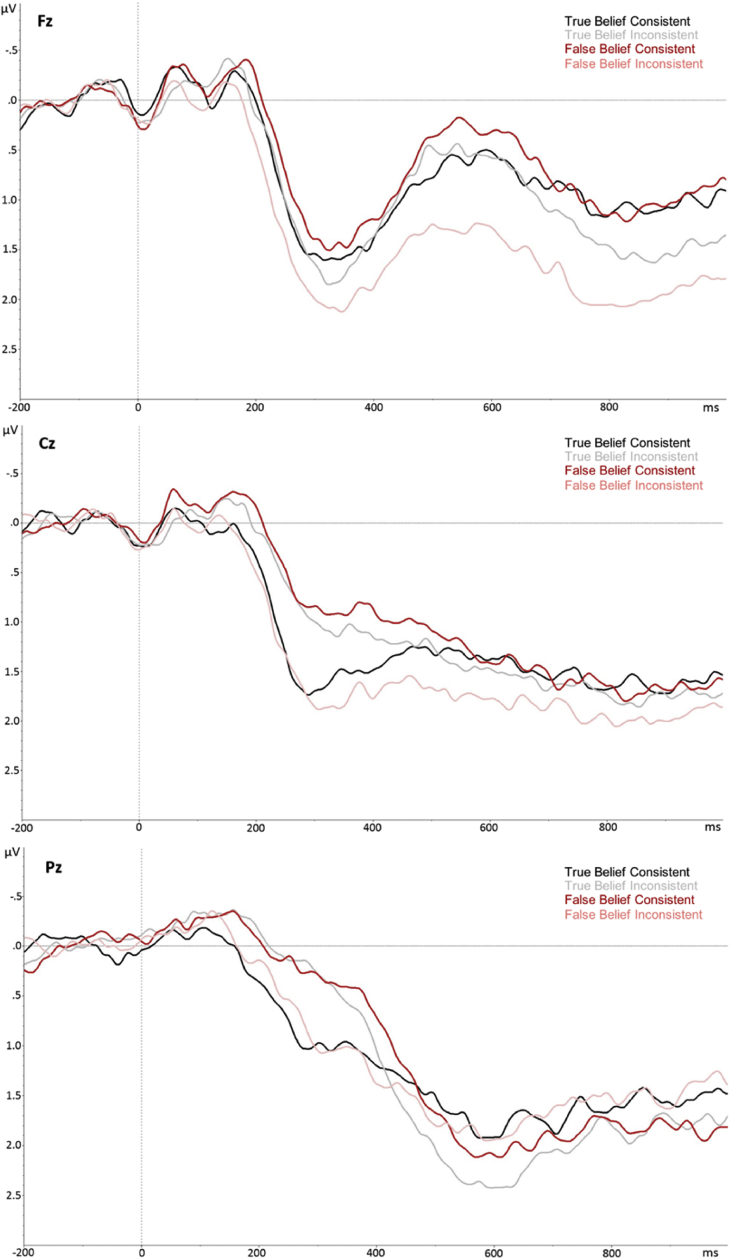
Grand average ERPs over midline electrodes elicited by critical words in the target sentence for each of the four conditions. Note that negativity is plotted upwards.